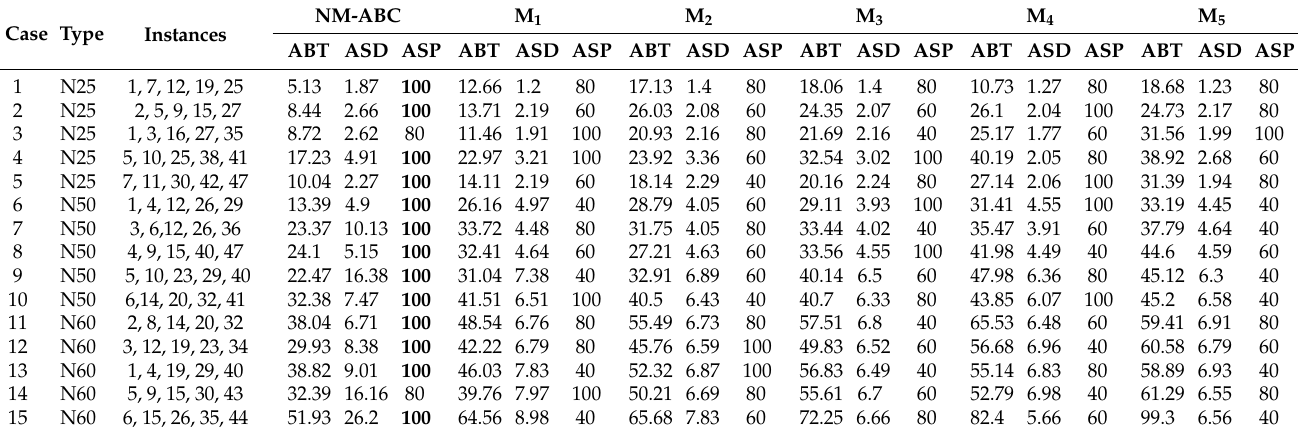
Table 6. Comparison and assessment of ABT, ASD, and ASP obtained by proposed algorithm NM-ABC and competitor